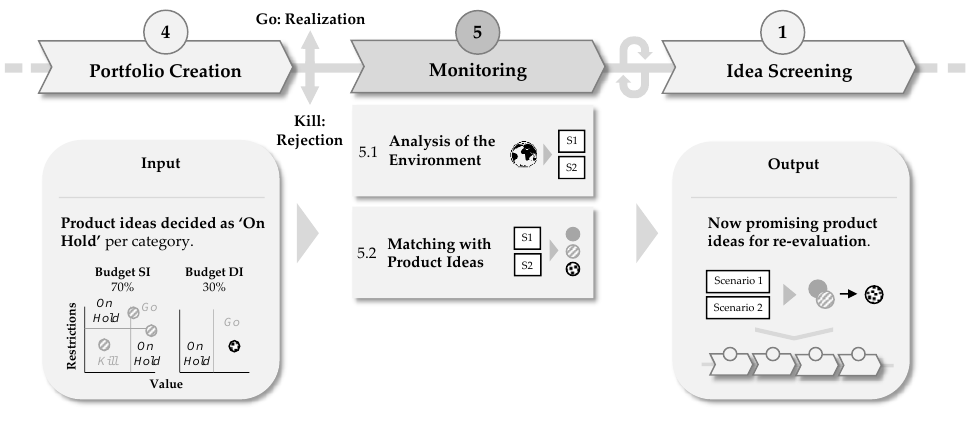
Figure 6. Monitoring: Input/output and procedure.